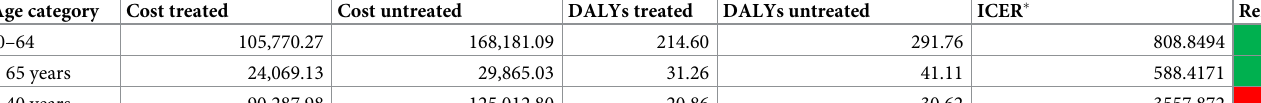
Table 6. Projected average annual incremental results of treating adults with untreated hypertension without diabetes, and or chronic kidney diseases between the ages of 33 and 64 Years (2020–2030). Age category Cost